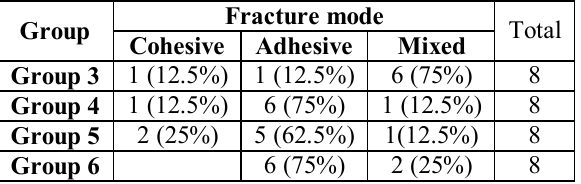
Table 5: Fracture mode of the restored samples